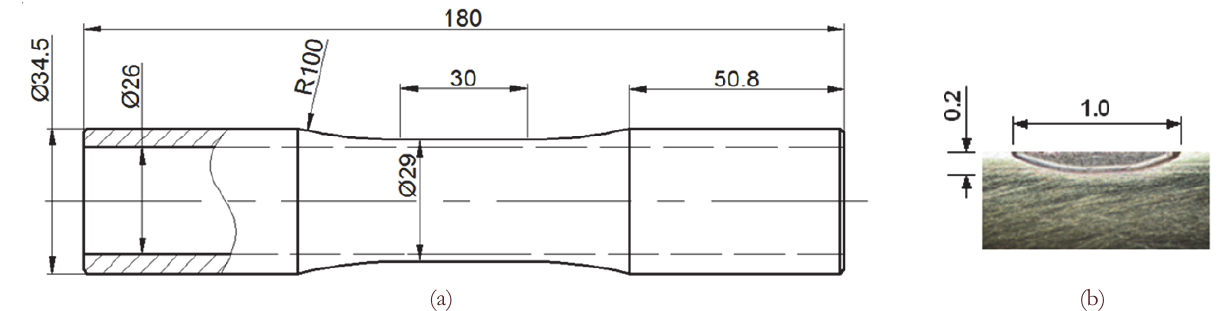
Figure 1: Test specimen details for (a) thin-walled tubular specimen geometry and (b) sectioned view of machined precrack notch. All dimensions are in